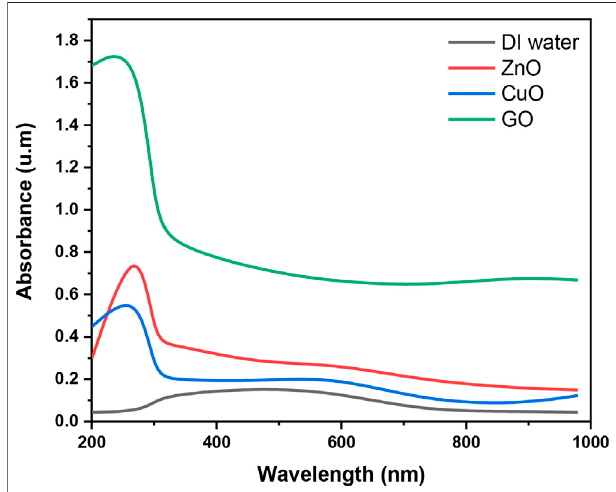
FIGURE 2 | UV-Spectra of DI water based nano fl